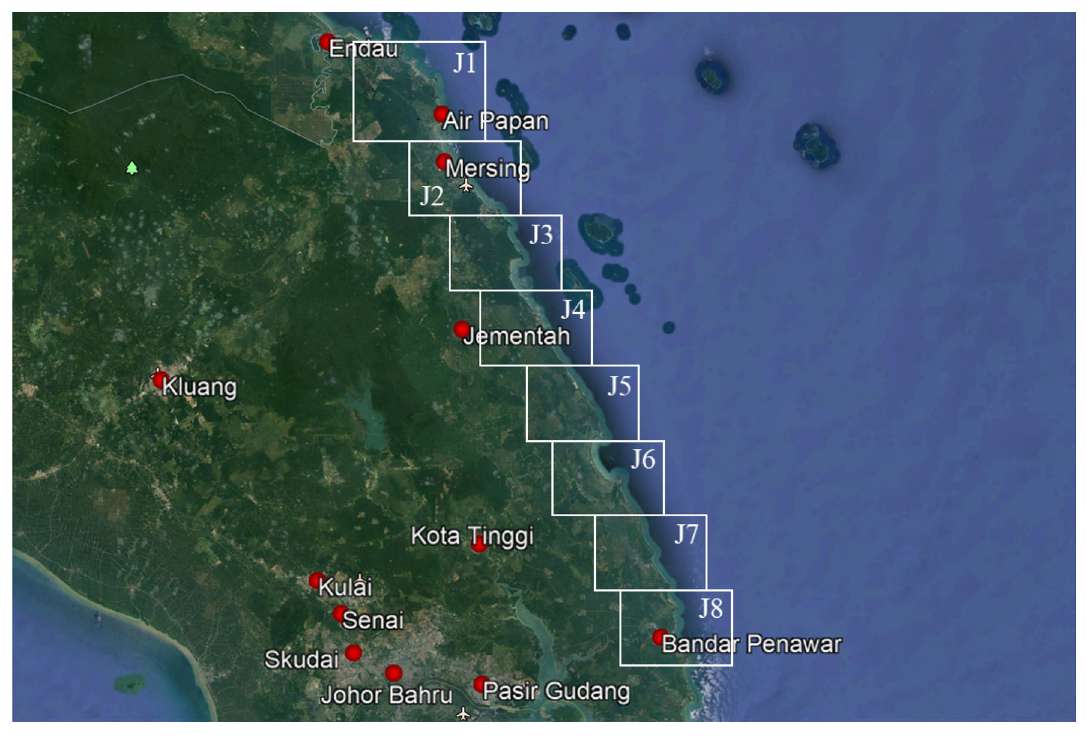
Fig. 11 Parcels (J1–J8) of inundation map in Johor